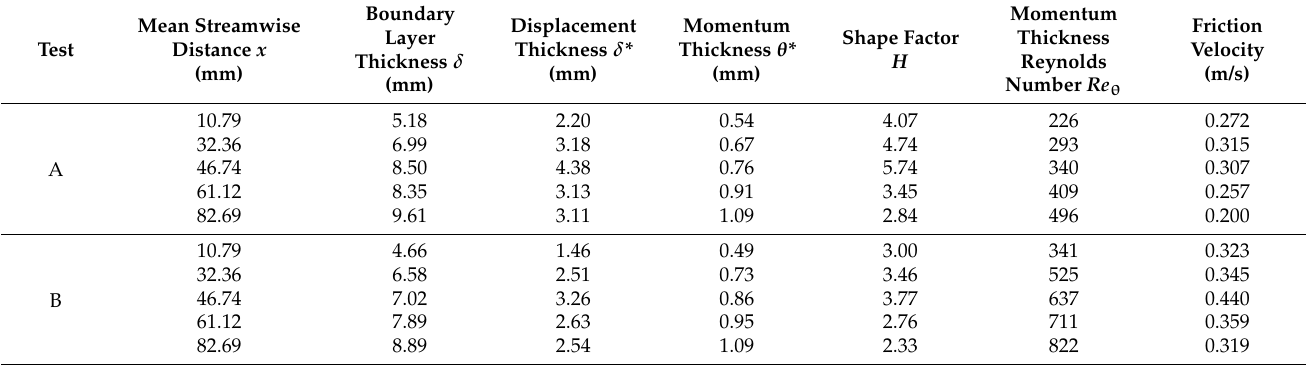
Table 4. Boundary layer and friction parameters for flow over porous media in the midspan plane.